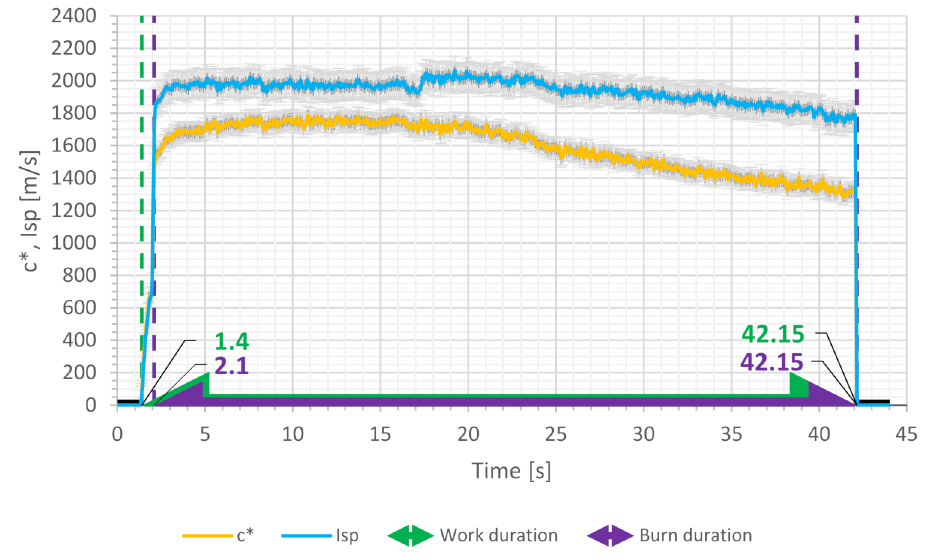
Figure 8. Results of test-bench hot-firing of the Mk2019+ hybrid rocket motor: the characteristic velocity and specific impulse obtained are shown, including their determination